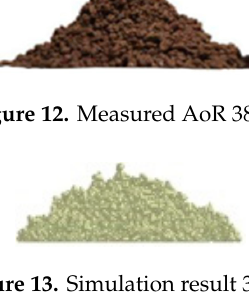
Figure 12. Measured AoR 38.65° Figure 13. Simulation result 38.54° Figure 13. Simulation result 38.54